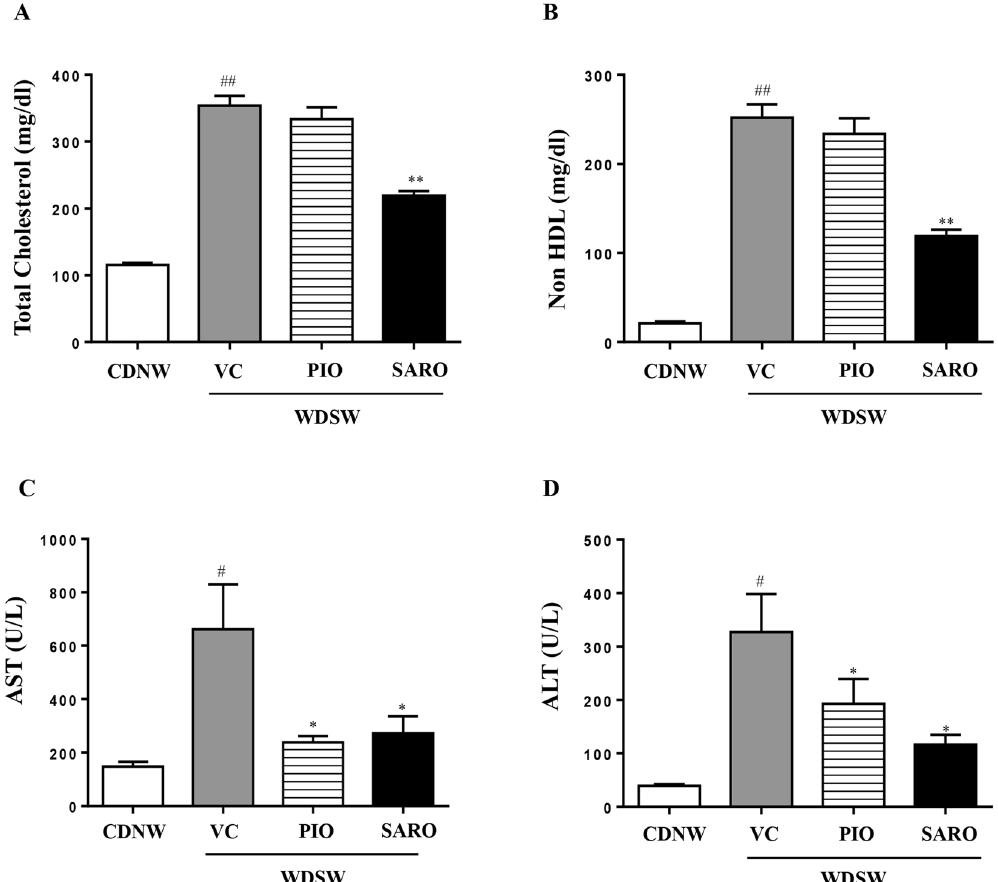
Figure 2. Saroglitazar decreased liver injury and dyslipidemia. DIAMOND mice fed CDNW or WDSW for 12 weeks were administered pioglitazone, saroglitazar or vehicle control for another 12 weeks. At the end of 24 weeks following dietary intervention and treatment, mice were fasted overnight and blood was collected. ( A ) serum cholesterol, ( B ) serum non HDL, ( C ) serum AST, ( D ) serum ALT. Data are expressed as the mean ± SEM for 6–12 mice per group. # p < 0.05, ## p < 0.001 compared to CDNW; * p < 0.05, ** p < 0.001 compared to WDSW, vehicle control. HDL, high density lipoprotein; AST, aspartate aminotransferase; ALT, alanine